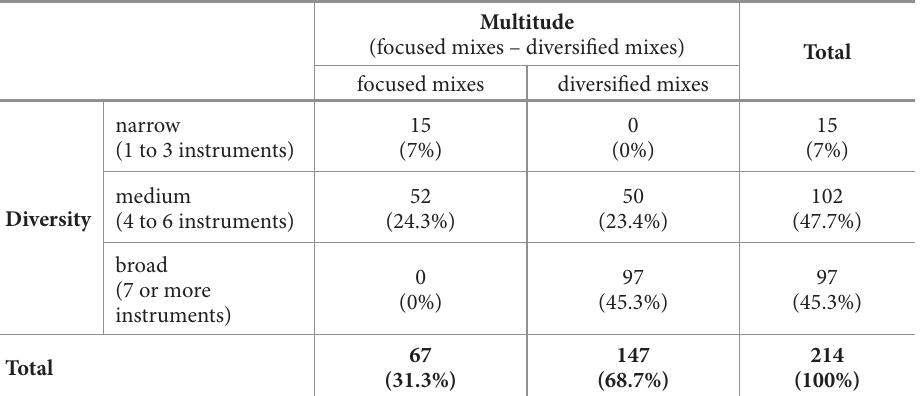
Table 2. Typology of hybrid media